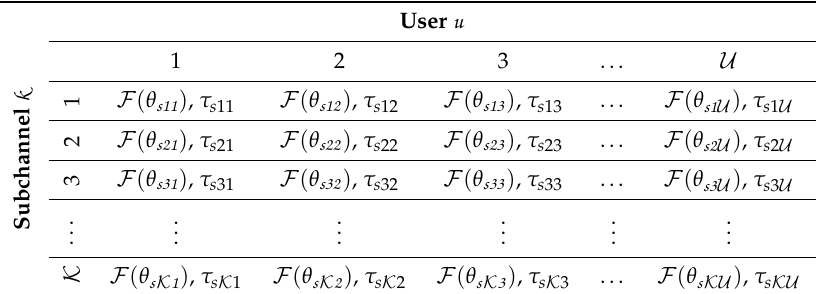
Algorithm 2 Update β